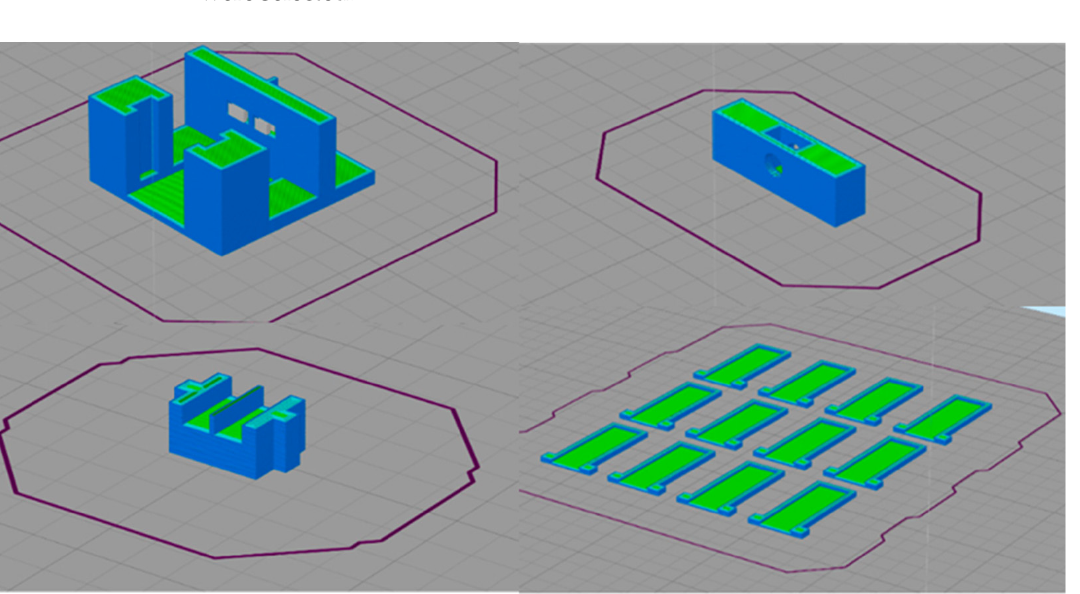
Figure 7. Connector slicing process.